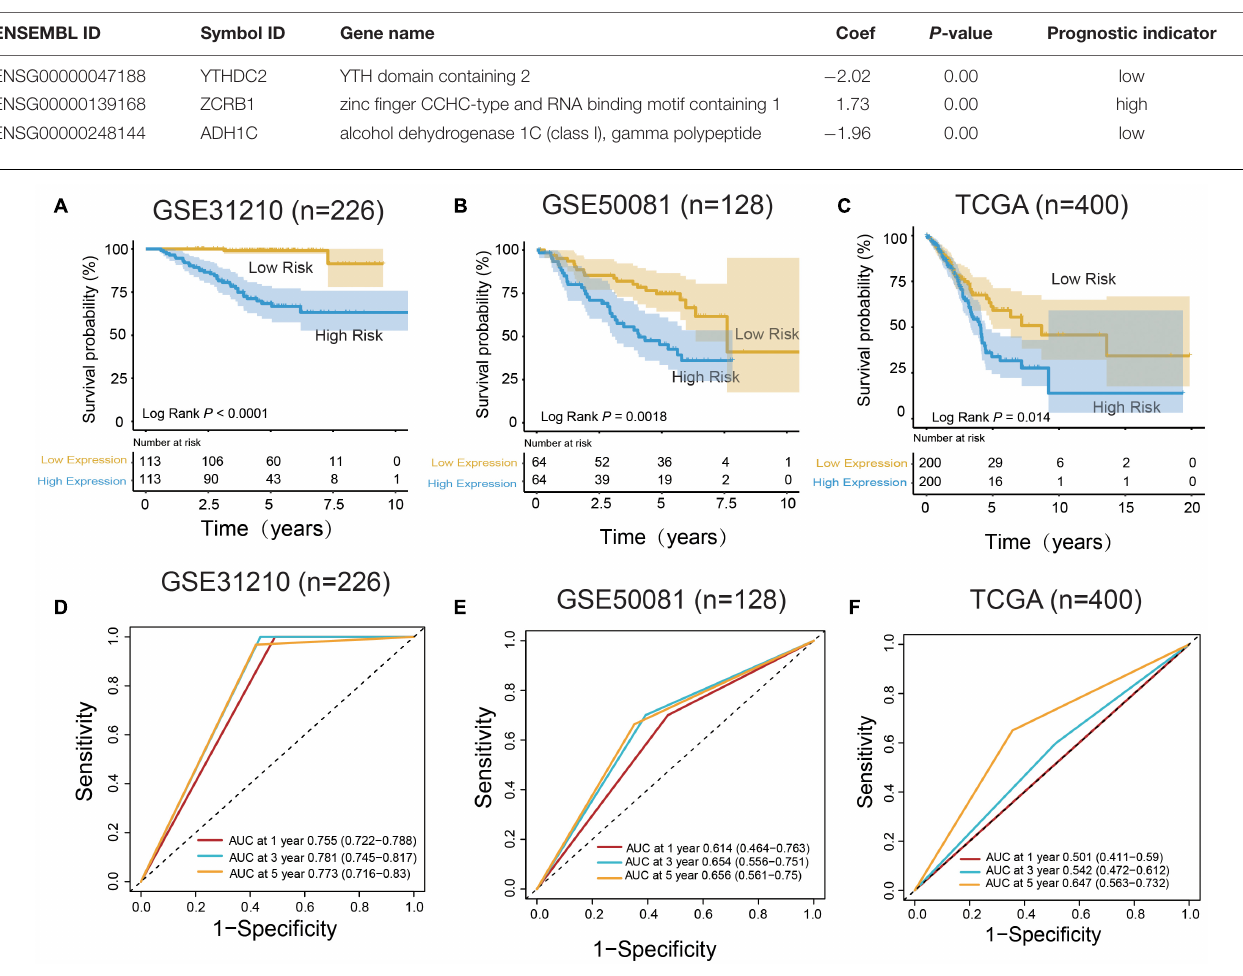
Frontiers in Genetics |